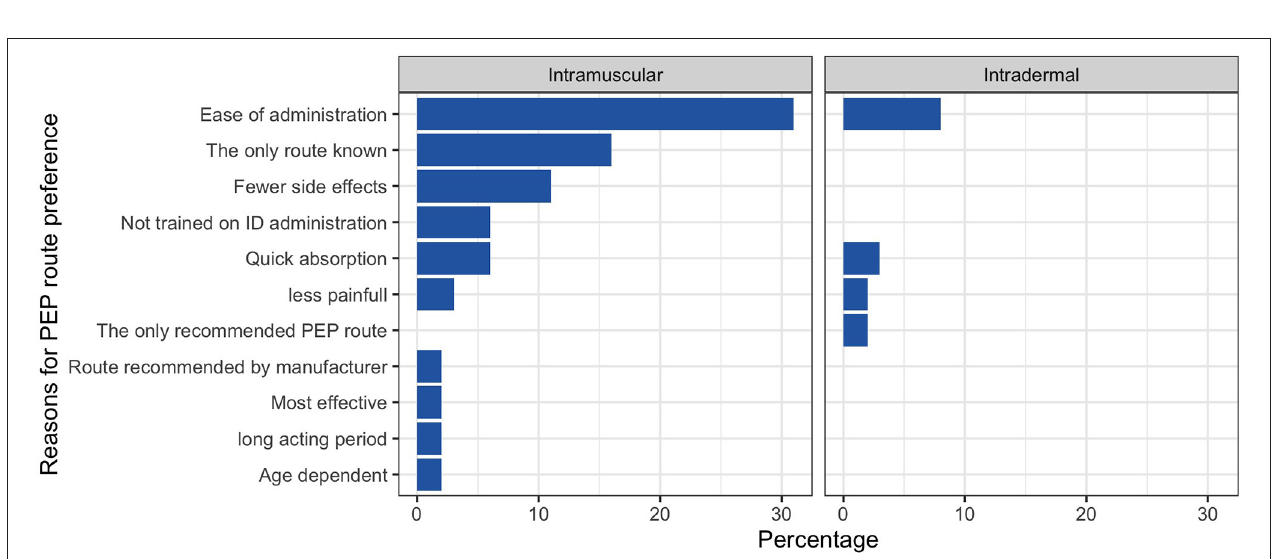
FIGURE 3 | Reasons for preference of each route of rabies vaccine administration among the healthcare